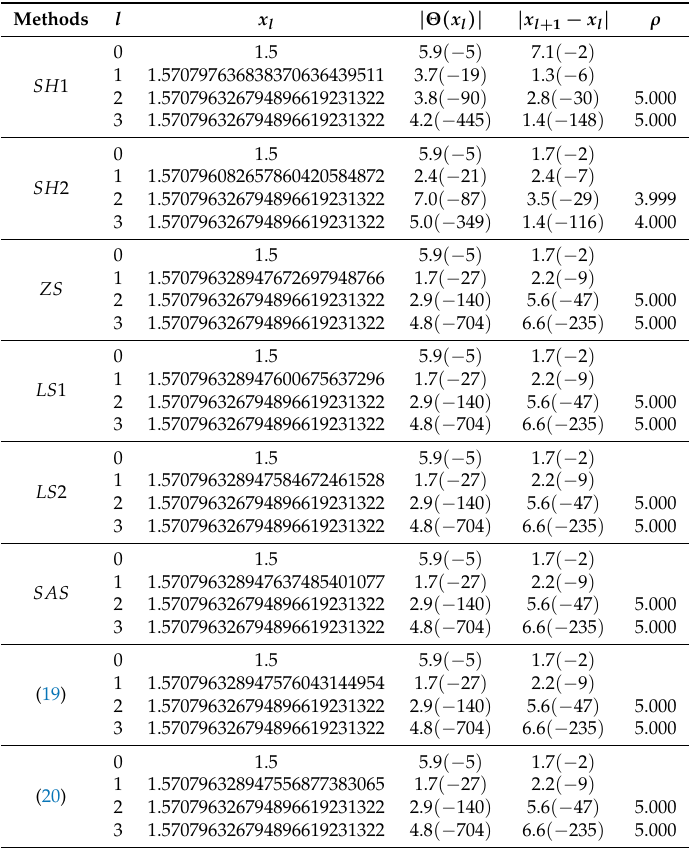
Table 1. Convergence study of distinct iterative functions on Θ 1 ( x )